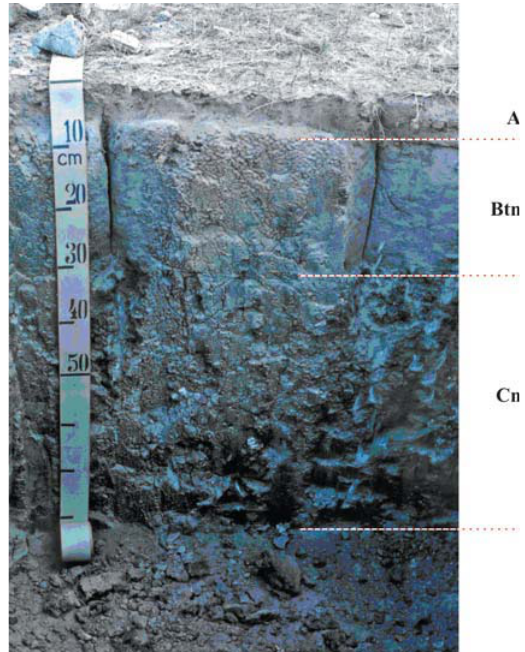
Figura 3. Perfil DJ-2 - Planossolo Nátrico órtico salino, em ambiente degradado de Jataúba,